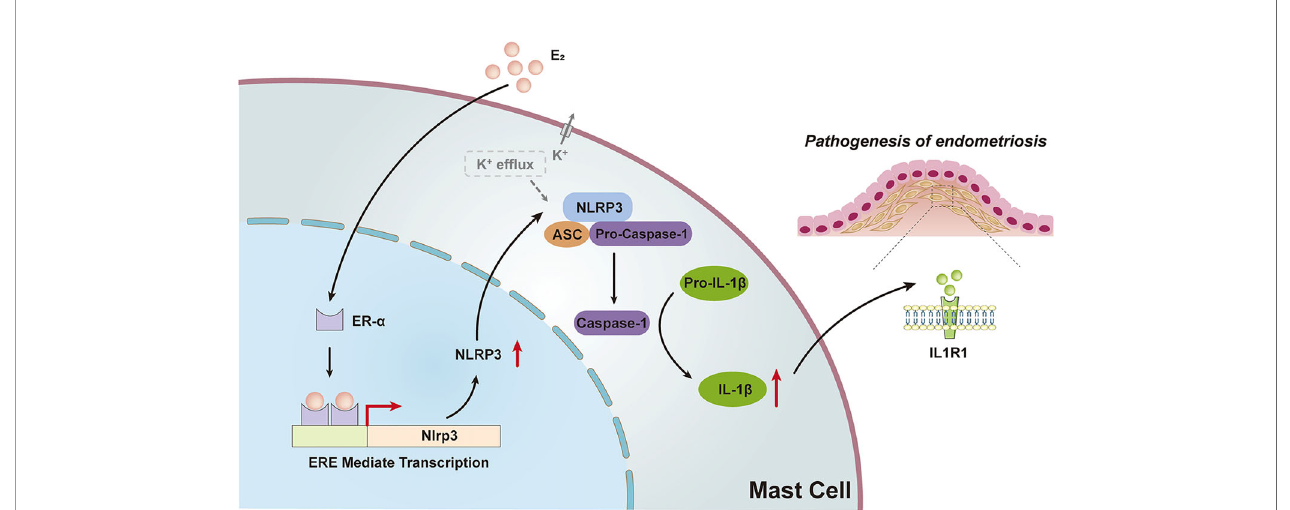
FIGURE 7 | Schematic diagram of the present fi ndings. High levels of estrogen in ovarian ectopic lesions can activate the NLRP3 in fl ammasome pathway by promoting ERE mediated transcription via ER- a in MCs. Increased expression of NLRP3 and K + ef fl ux activated the recruitment of in fl ammasomes, leading to the activation of caspase-1 and ultimately the production and secretion of functional IL-1 b , which may trigger the pathogenesis of